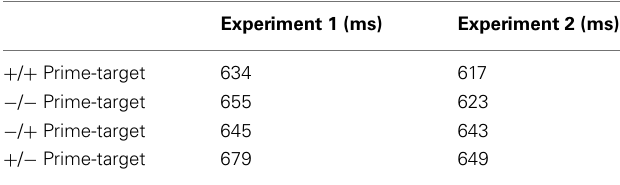
Table 1 | Reaction times (in ms) as a function of prime-target combination in Experiment 1 and